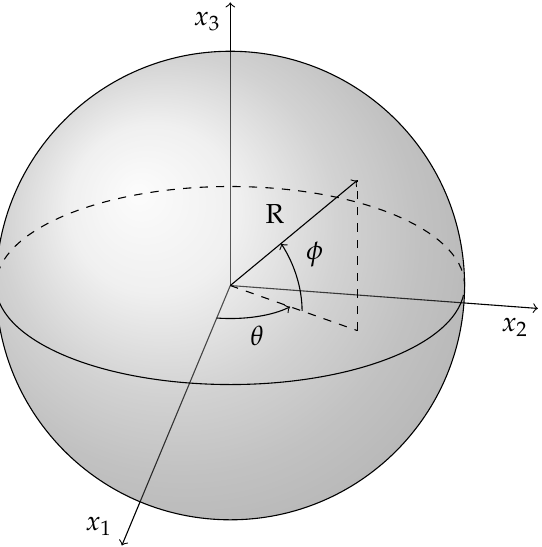
Figure 1. Coordinate transformation of relative